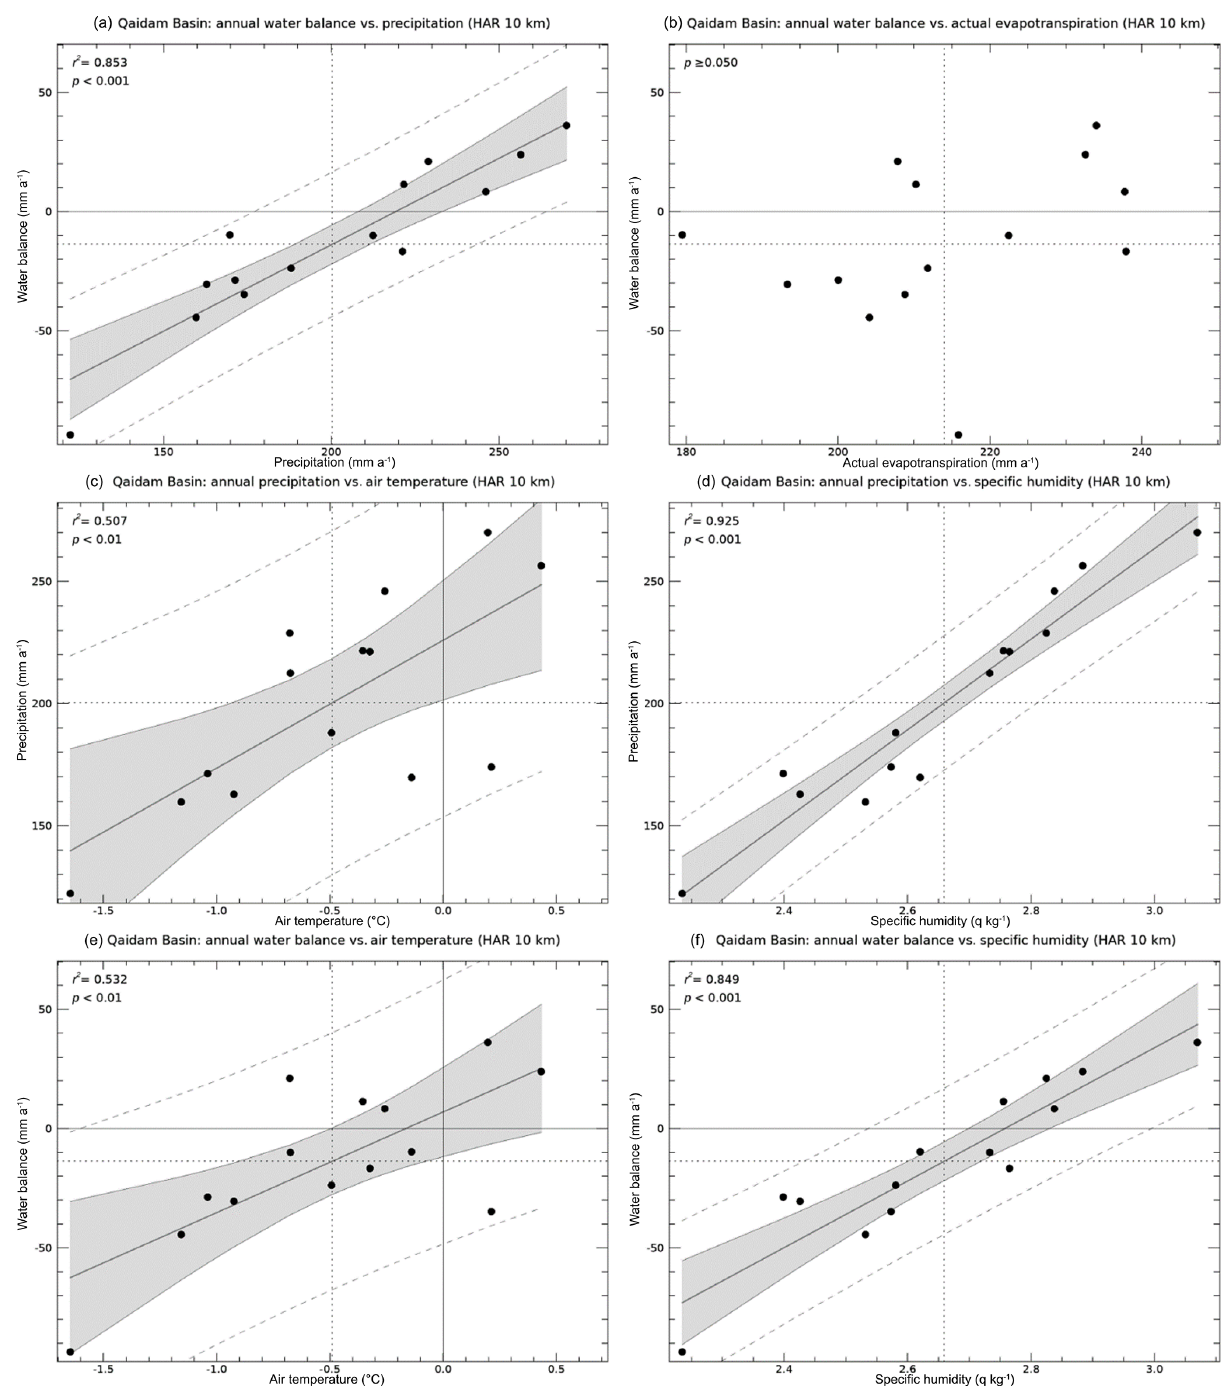
Figure 4. Water balance versus precipitation (a) and actual evapotranspiration (b) ; precipitation versus air temperature (c) and specific humidity (d) ; water balance versus air temperature (e) and specific humidity (f) in the Qaidam Basin (QB) during the hydrological years 2001 to 2014 derived from the HAR 10km data set. Dotted lines: mean annual values; solid lines: regression lines; light grey shades: confidence intervals; dashed lines: prediction